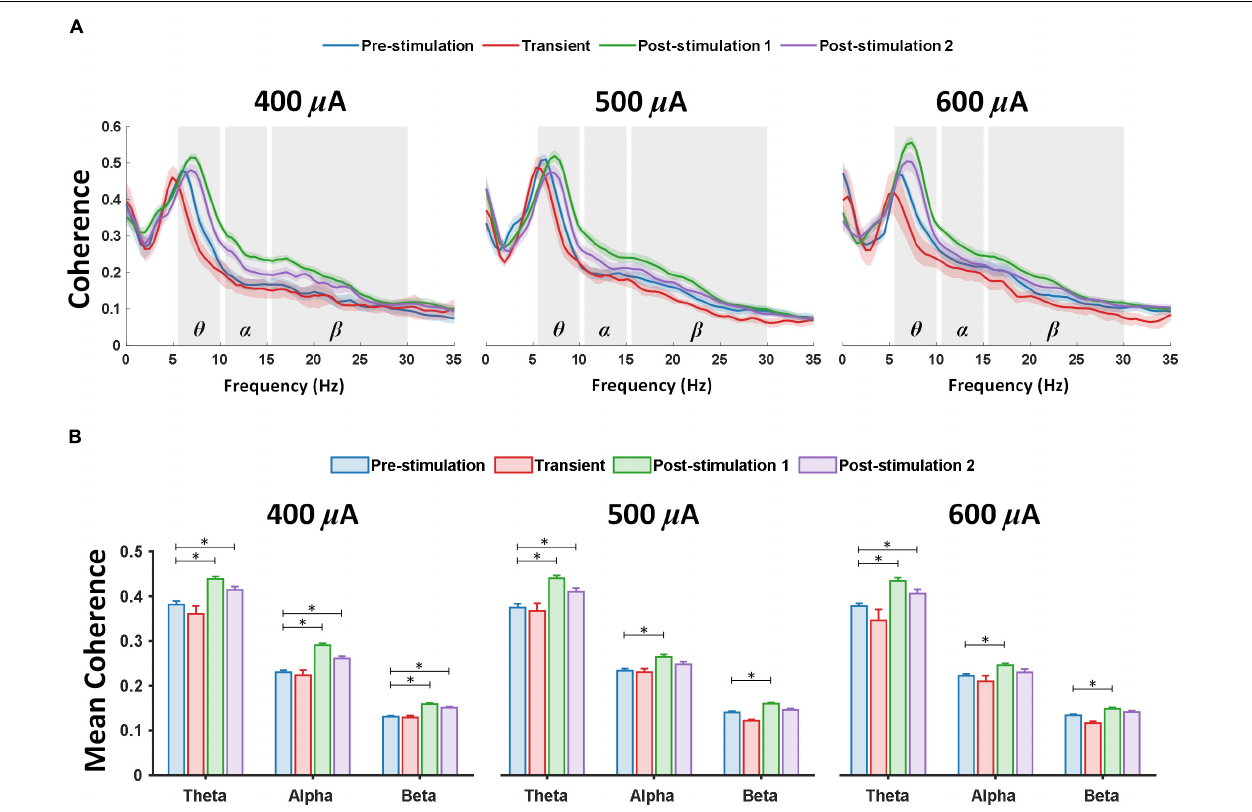
FIGURE 3 | Theta, alpha and beta coherence is markedly elevated between the left prefrontal cortex and left primary visual cortex after retinal electrical stimulation. (A) Coherence spectrum showed prominent enhancement in theta, alpha and beta frequency bands; the shaded area depicts SEM. (B) Mean coherence values over two ECoG channels (left prefrontal cortex and primary visual cortex) from 400 µ A stimulation ( n = 6), 500 µ A stimulation ( n = 6), 600 µ A stimulation ( n = 6) during pre-stimulation (baseline), transient stimulation, post-stimulation stage 1 and post-stimulation stage 2. ∗ Significant ( P < 0.025); Error bar denotes